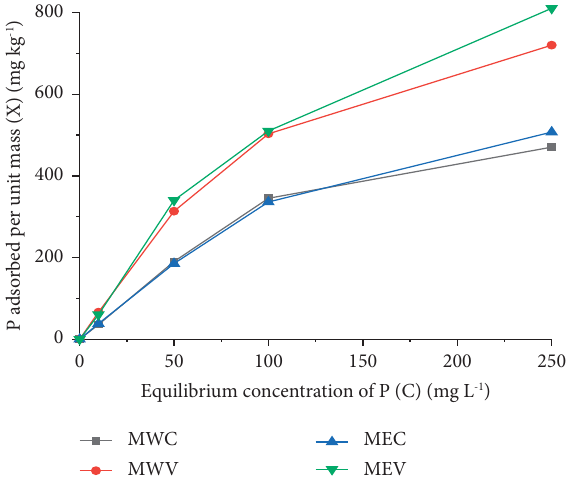
Figure 1: Phosphorus adsorbed as a function of the equilibrium concentration of the soil (24hours equilibration at 25 ° C).